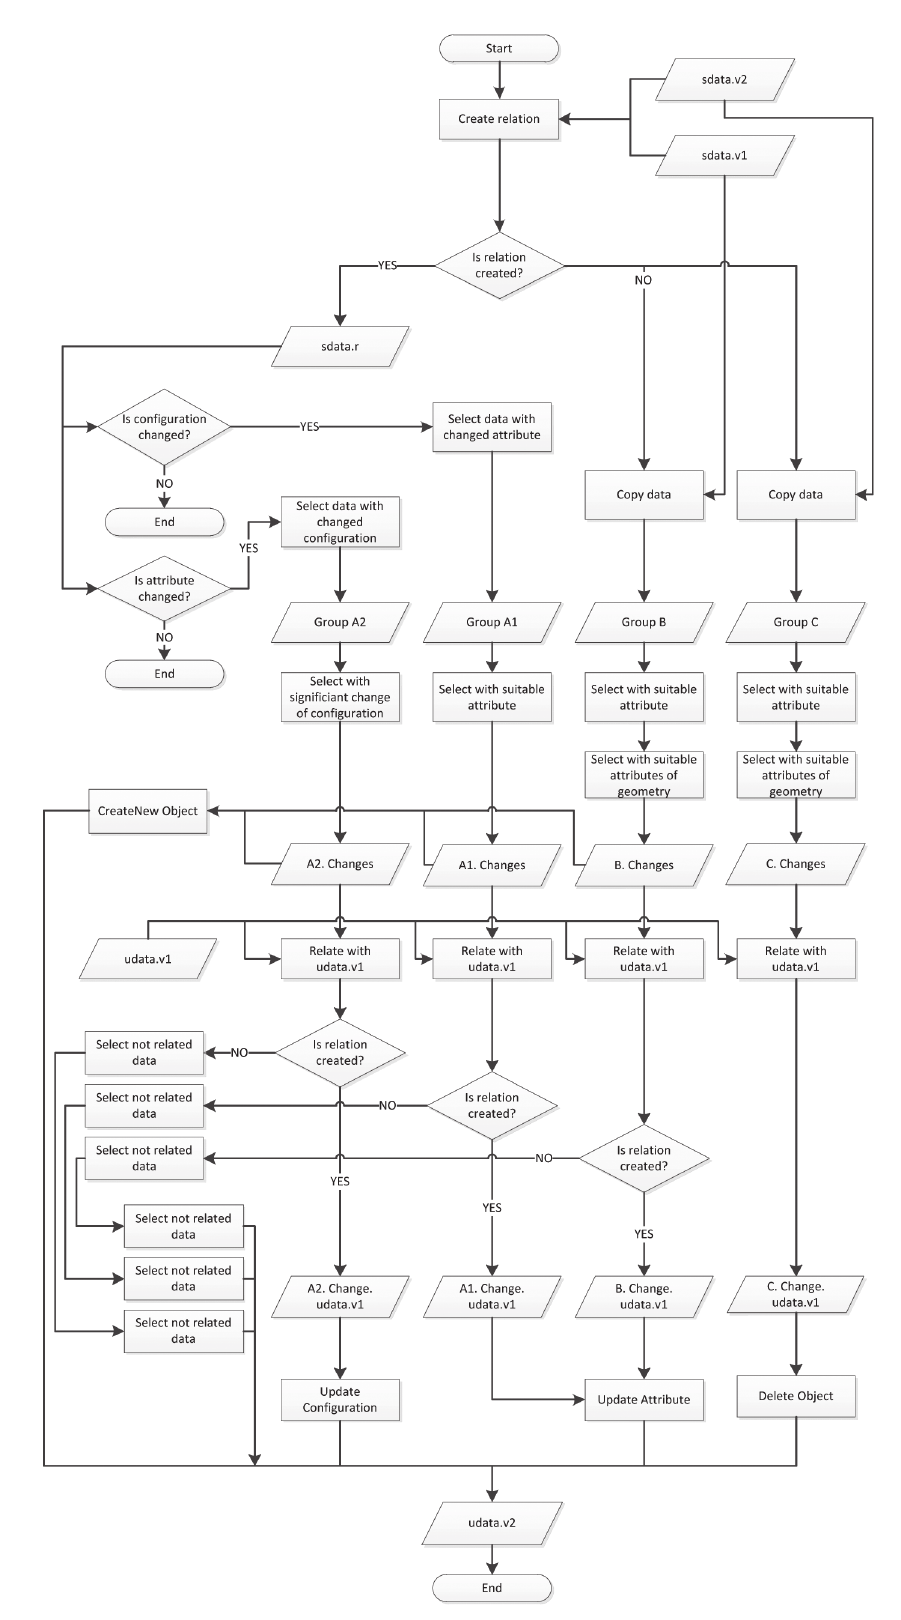
Fig. 6. A model for detecting changes in a cartographic